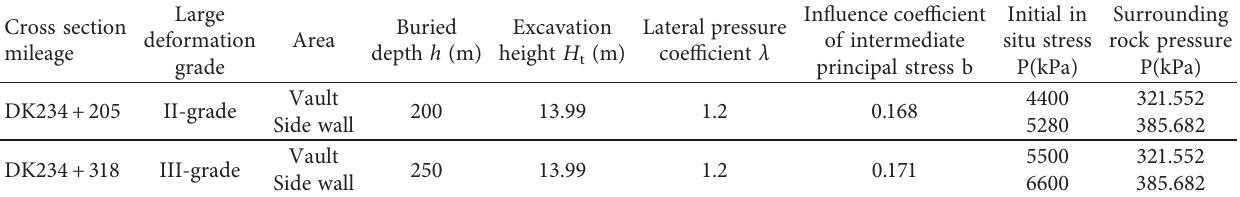
Table 5: Calculation table of surrounding rock pressure.